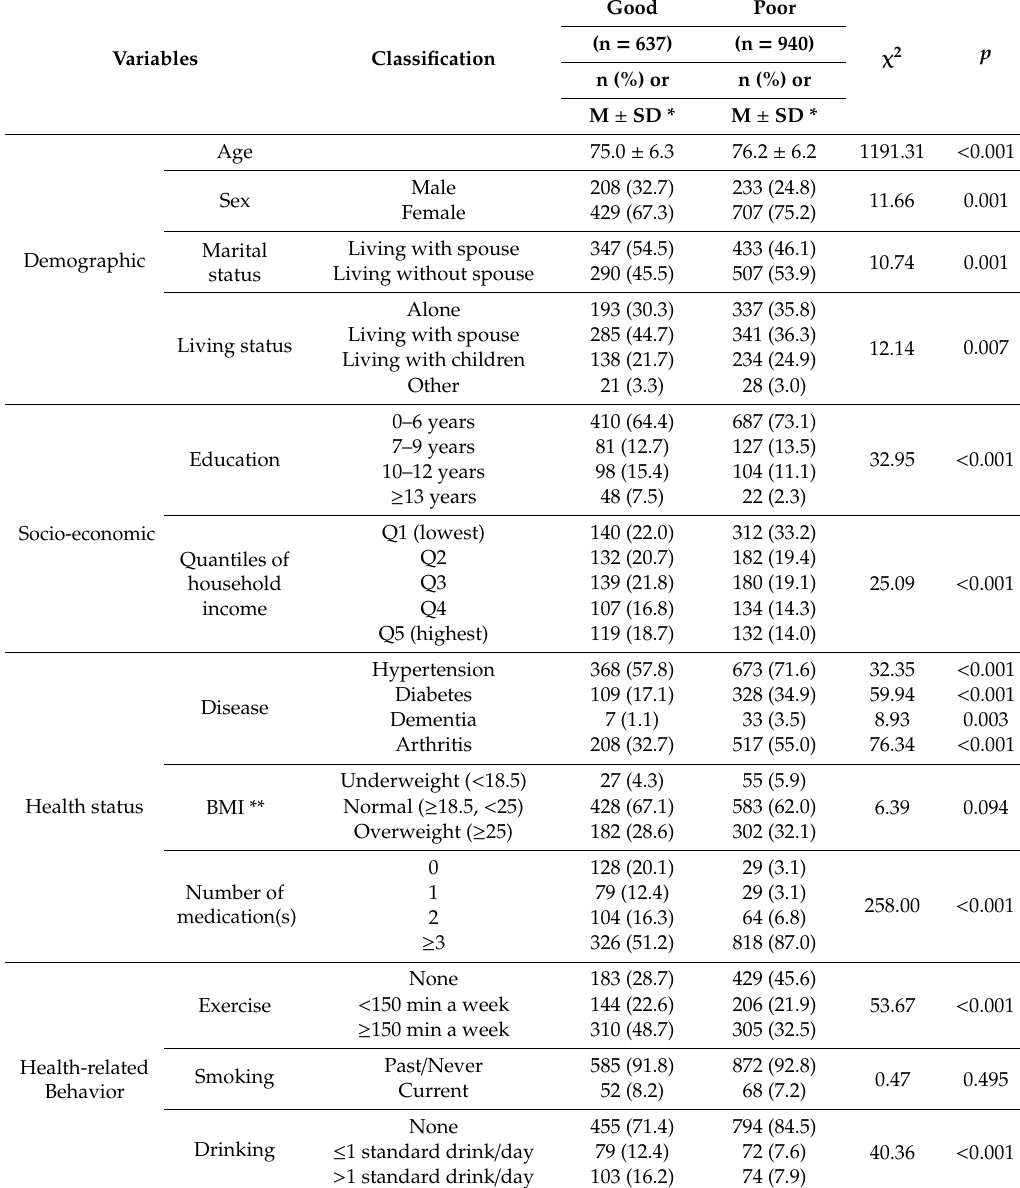
Table 1. Di ff erences in individual characteristics between those with good and poor self-reported health statuses (n =